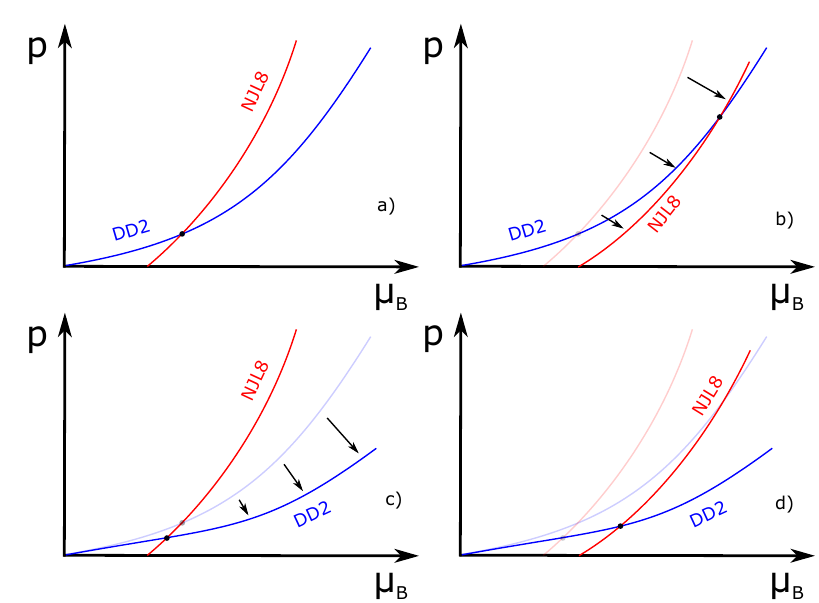
Figure 1. Generic systematics of the different possibilities of the hybrid Equation of State (EoS) within the density dependent relativistic mean field hadronic model with the DD2 parametrization and Nambu-Jona-Lasinio model with 8-quark interactions (DD2-NJL8) hybrid EoS model in terms of the absence (soft EoS) or presence (stiff EoS) of the repulsive interactions: ( a ) soft-to-soft; ( b ) soft-to-stiff; ( c ) stiff-to-soft; and ( d ) stiff-to-stiff EoS.